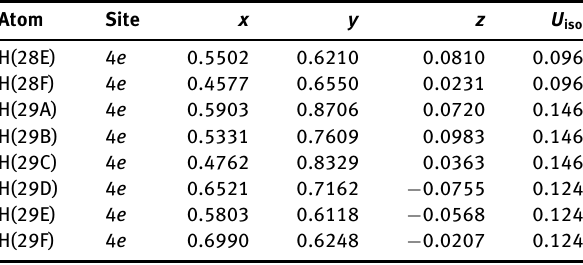
Table 3: Atomic coordinates and displacement parameters (in Å 2